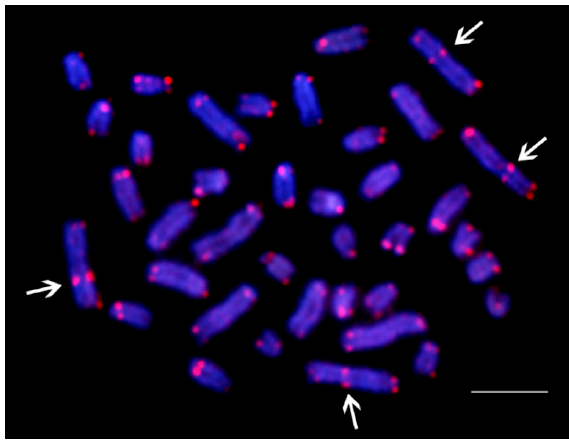
Figure 5. Metaphase plate of C. lopis hybridized with telomeric (TTAGGG) n probe. Arrows indicate interstitial telomeric site (ITS) in four chromosomes. Scale bar = 5 μ m.